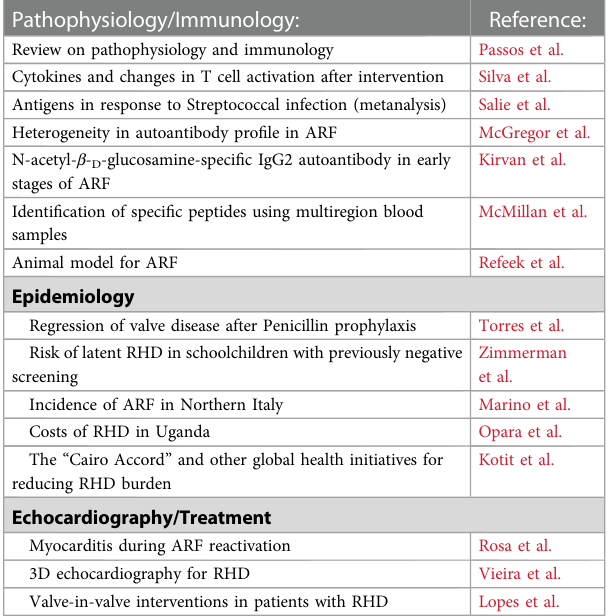
TABLE 1 Manuscripts published in the special issue: rheumatic fever: 21st century clinical and experimental